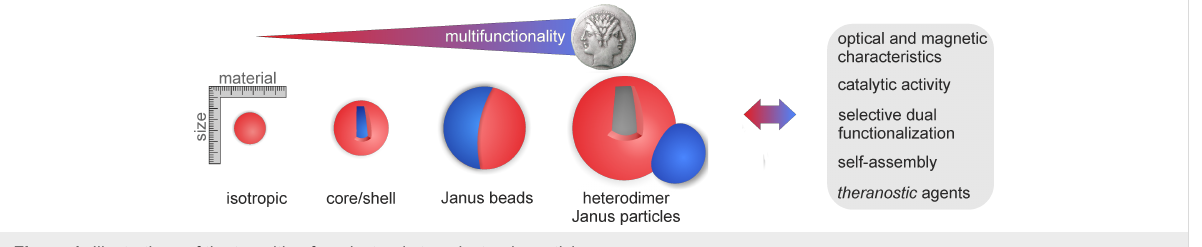
Figure 1: Illustrations of the transition from isotropic to anisotropic